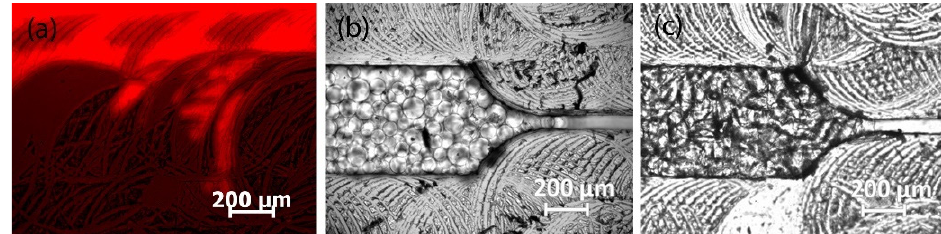
Figure 19. Microfluidic chip replica fabricated through milling on ABS. ( a ) Leakage visualized with fluorescent rhodamine B solution. ( b ) Narrow sieve retaining spherical particles. ( c ) Narrow sieve retaining non-spherical particles.